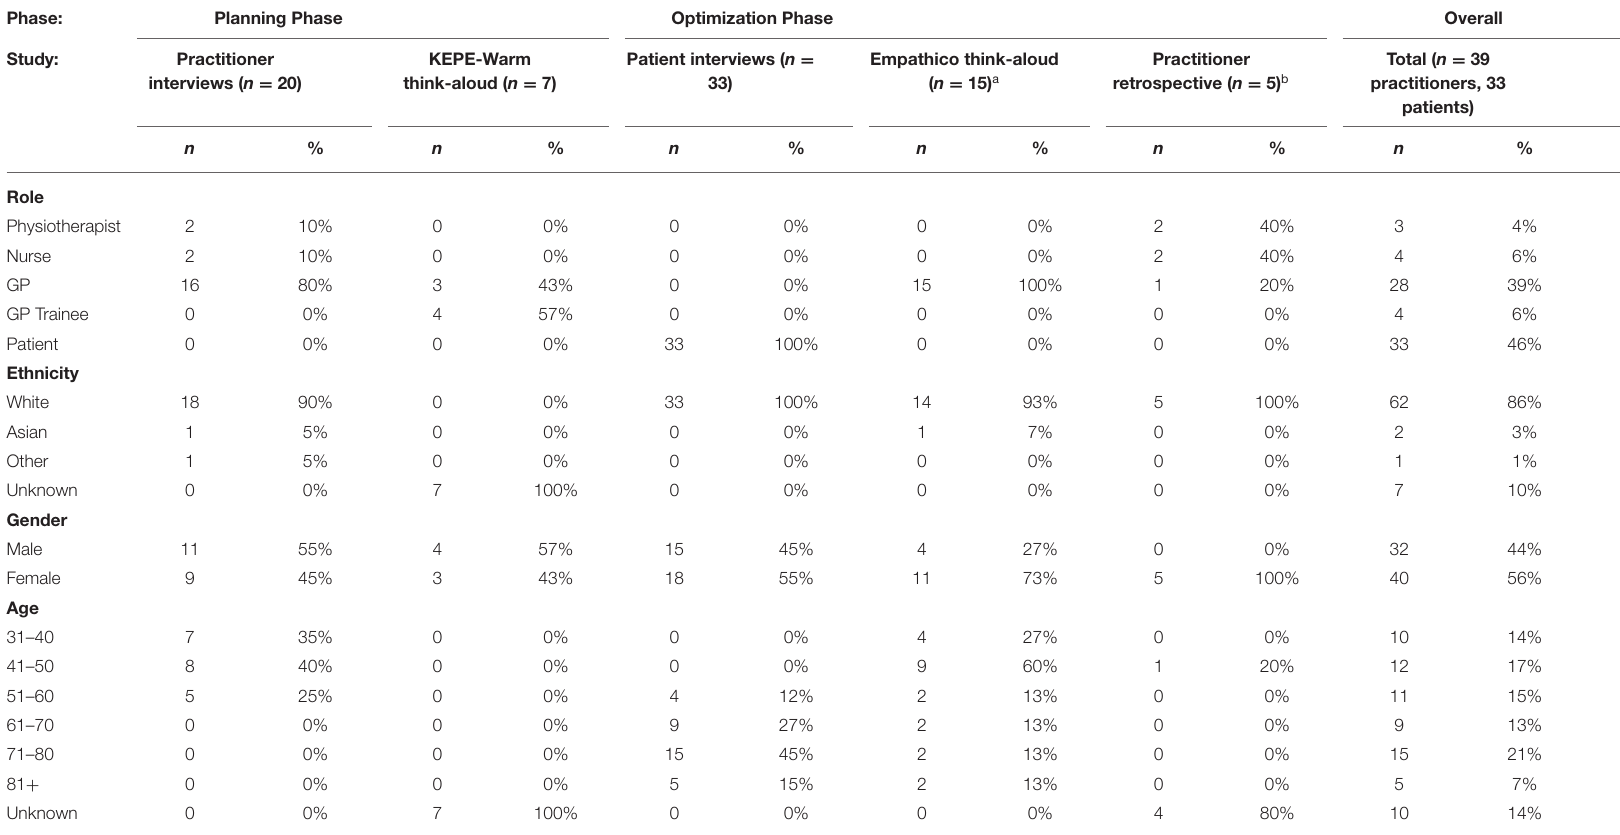
TABLE 2 | Demographic characteristics of study